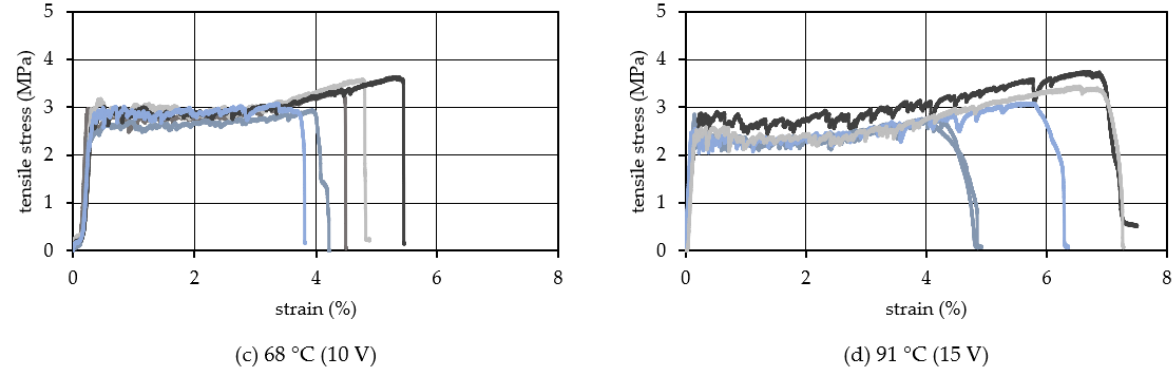
Figure 9. Tensile stress strain relationship (Vf: 2.00 vol.%).